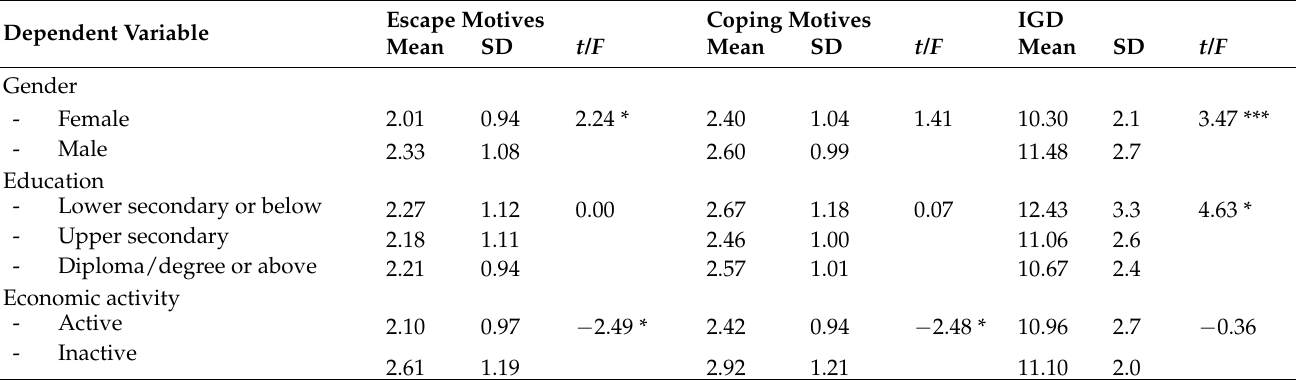
Table 2. Means and Standard Deviations of the Dependent Variables (Gaming Motivations and Internet Gaming Disorder, or